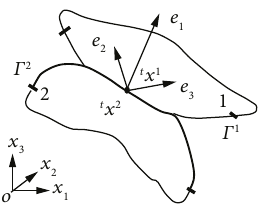
Figure 1: Contact-impact interface